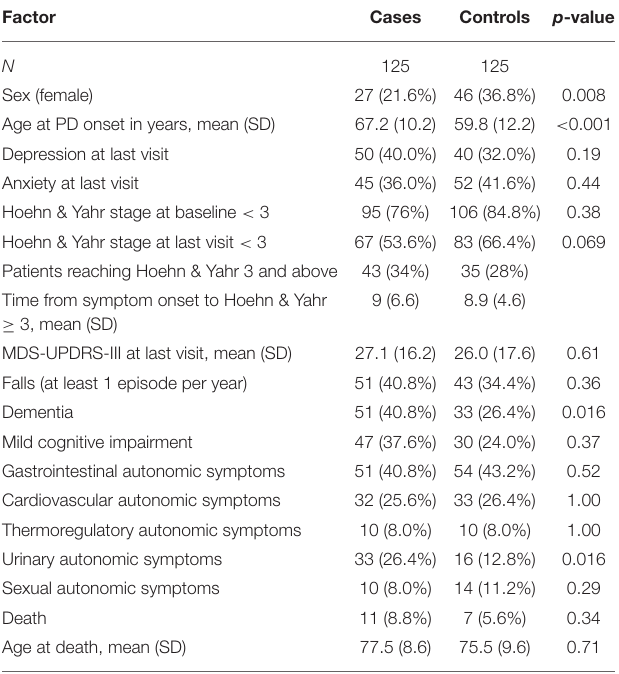
TABLE 1 | Comparison of clinical profiles of cases and controls.